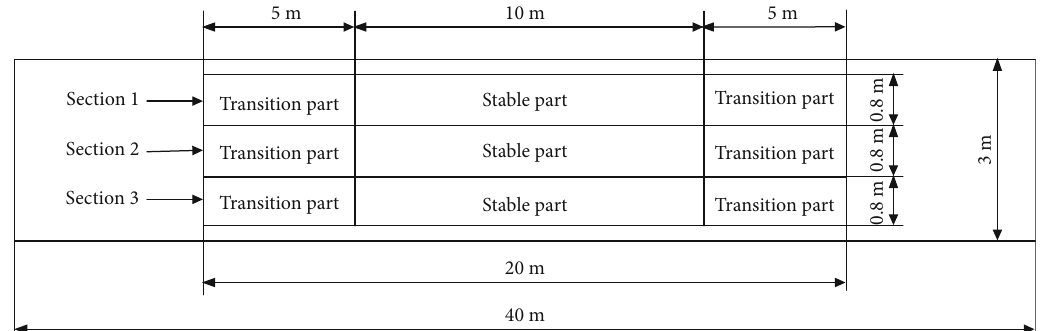
Figure 7: Scheme of three sections in the soil bin.